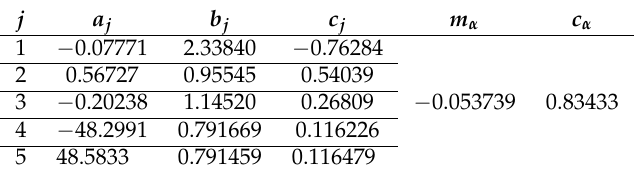
Table A6. Coefficients for α V